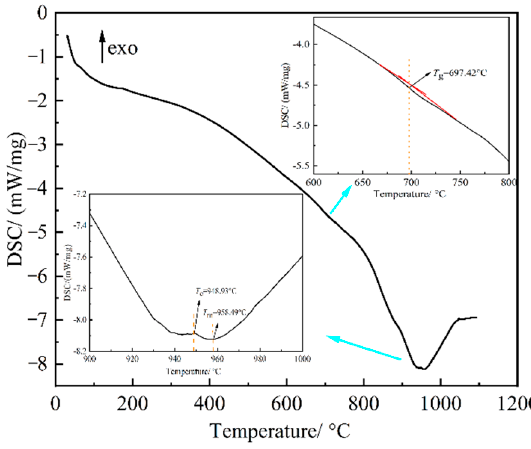
Figure 2. DSC curves of the base glass.